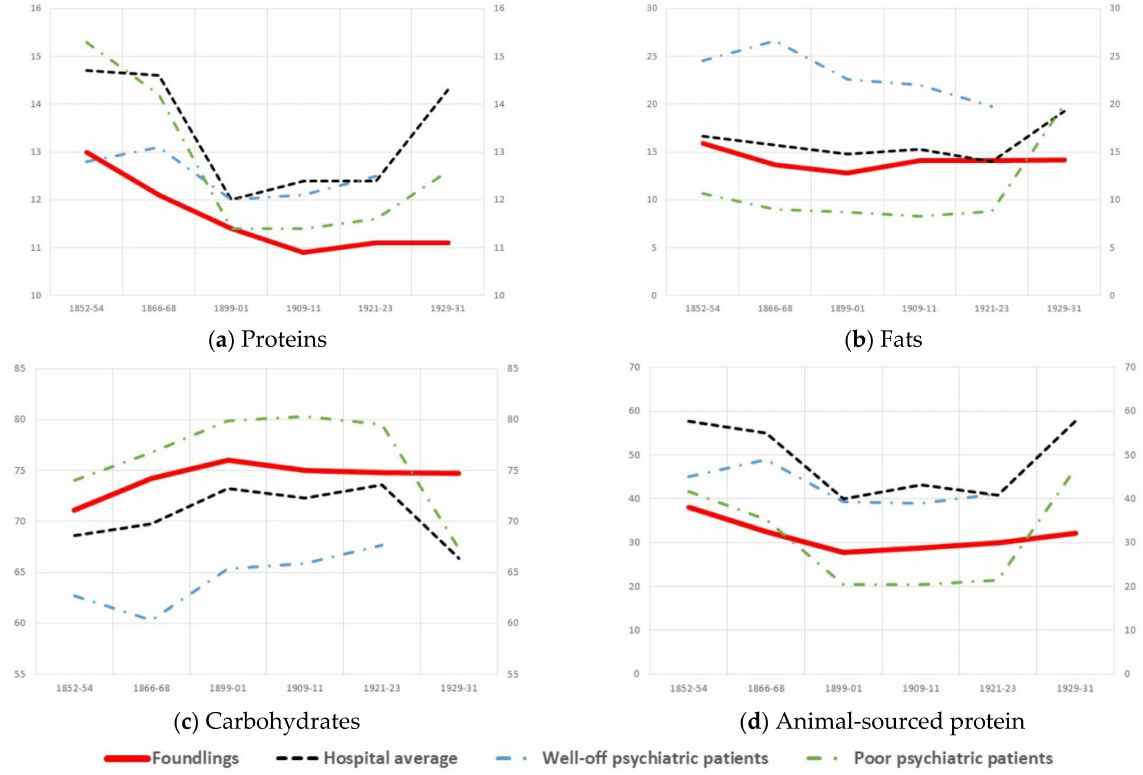
Figure 1. Distribution of macronutrients (in percentage) ( a – c ) and percentage of animal proteins ( d ) in the average daily diet of foundlings and other population groups in the Hospital General de Valencia, 1852–1931 (%). Source: see Tables 1–3. Data of well-off psychiatric patients and poor psychiatric patients: